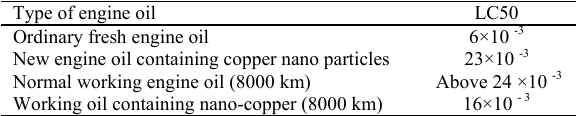
Table 10. LC50 value after 48 hours on paper test in ml/cm 2 Table 10: LC50 value after 48 hours on paper test in ml/cm 2